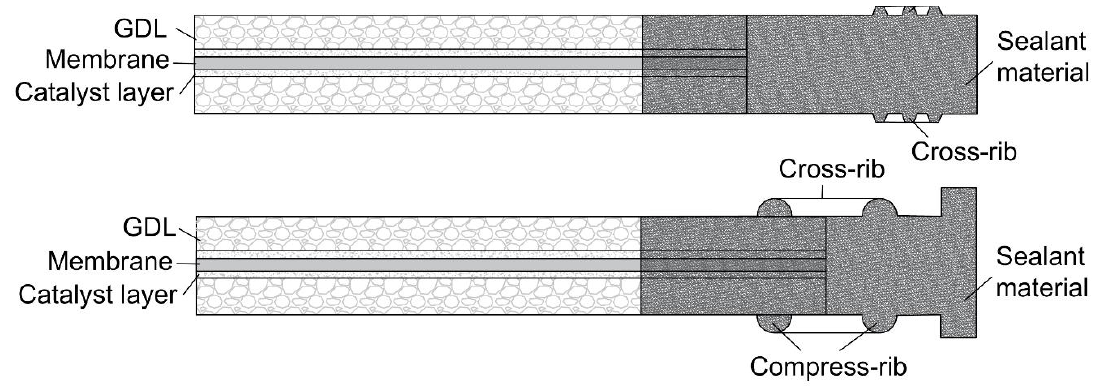
Figure 14. MEA-wrapped frame-sealing structure.